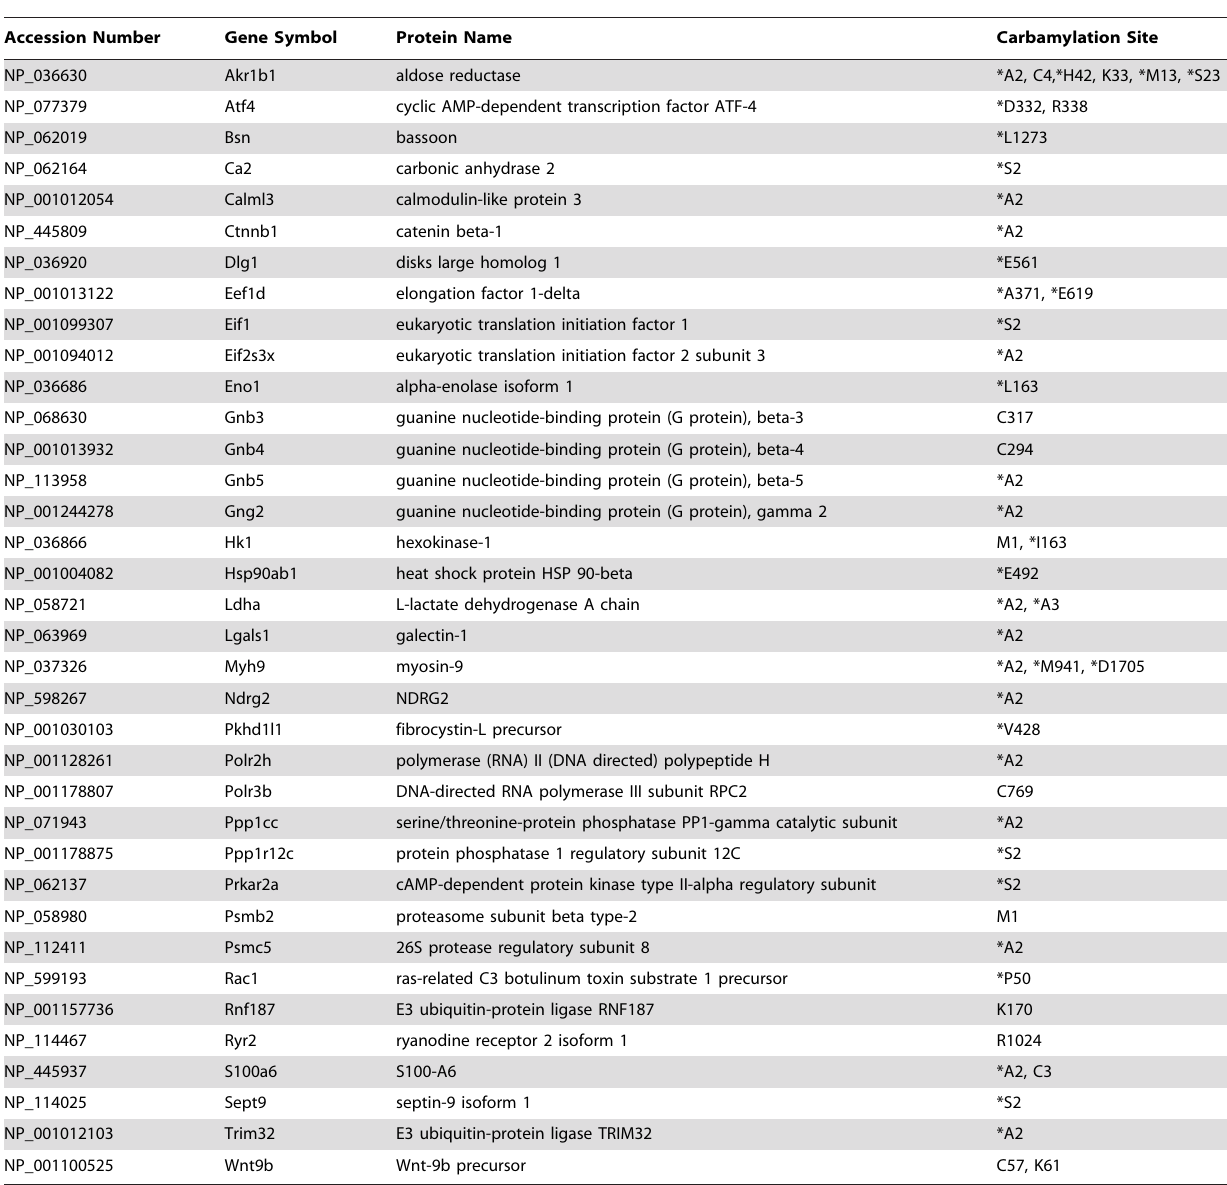
Table 1. Subset of Carbamylated Proteins with Potential Physiological